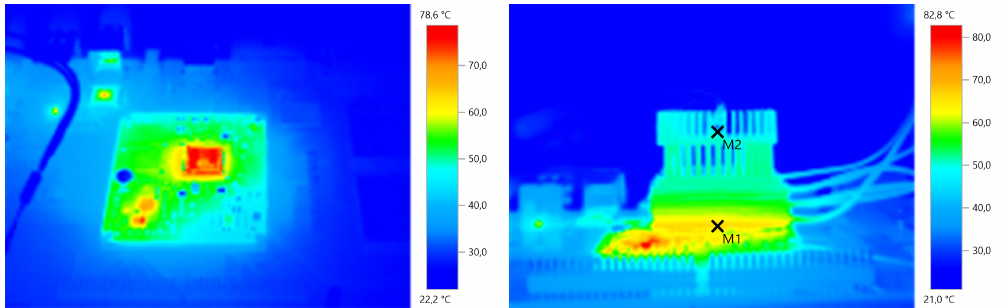
Figure 4. Thermal picture of the host equipped with the harvesting system during the experimental characterization. Left: seen from above; Right: side